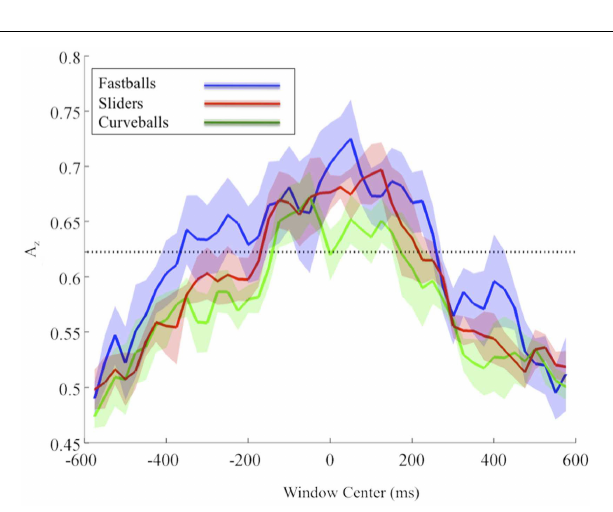
FIGURE 4 | Group mean and standard error bands for response-locked leave-one-out EEG discrimination performance across all subjects. The significance line (dotted) is corrected for multiple comparisons (line at p = 0.05, Bonferroni corrected for 47 time window